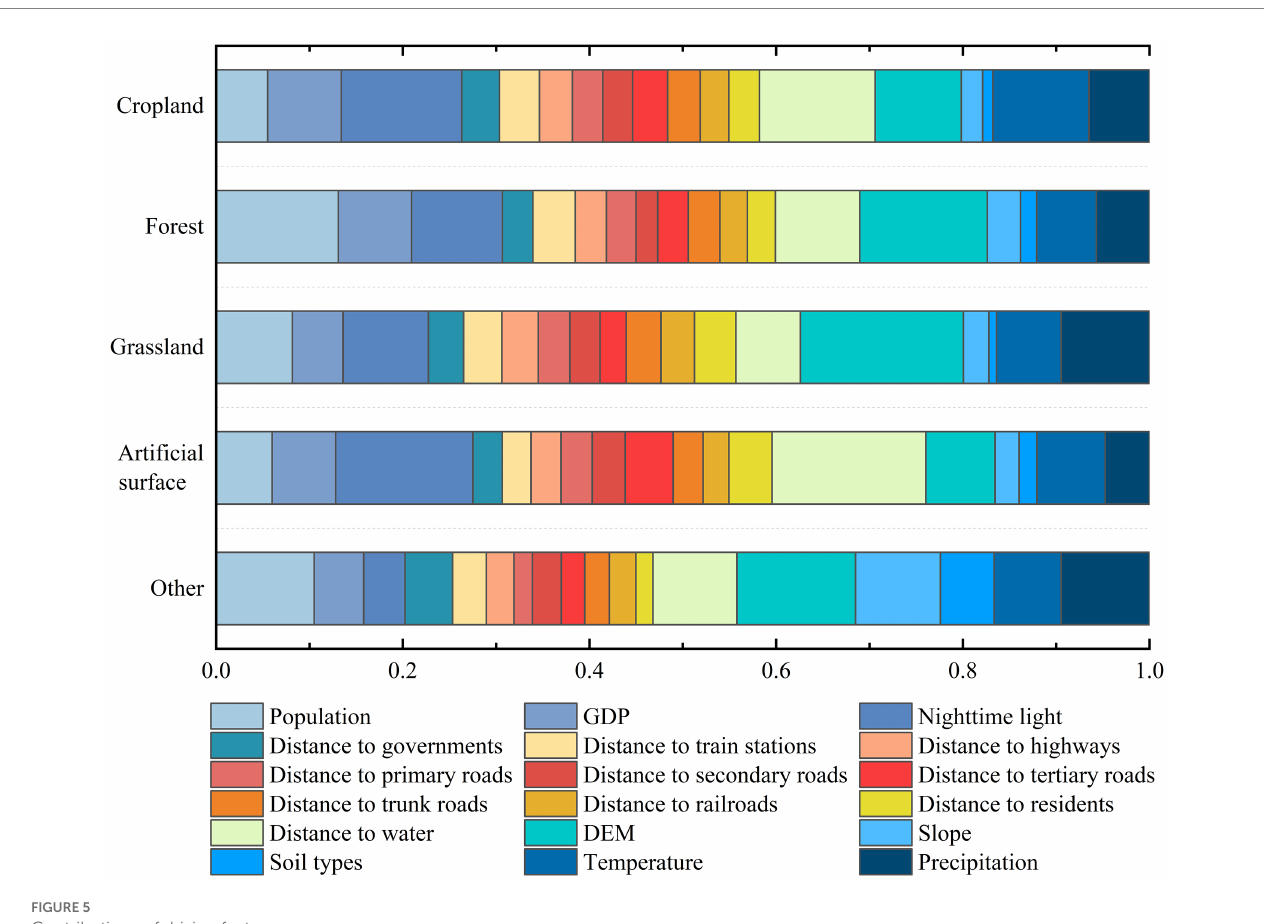
FIGURE 5 Contributions of driving